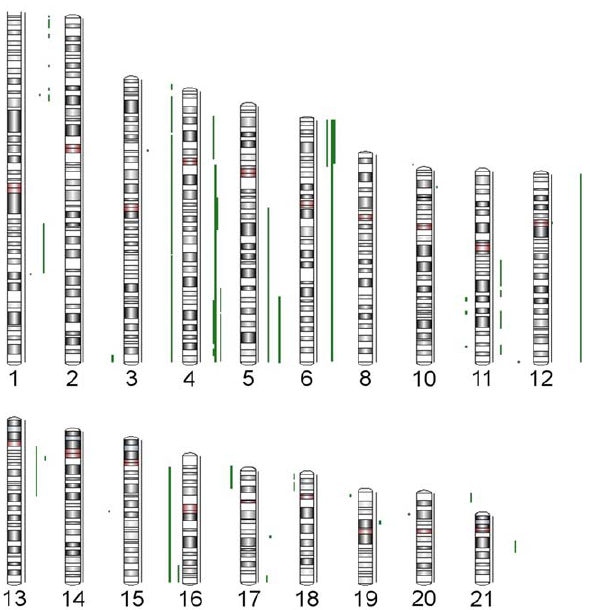
Figure 8. Regions of cnLOH found in this study’s CRC samples. Each vertical green line shows the occurrence copy-neutral LOH in one sample.